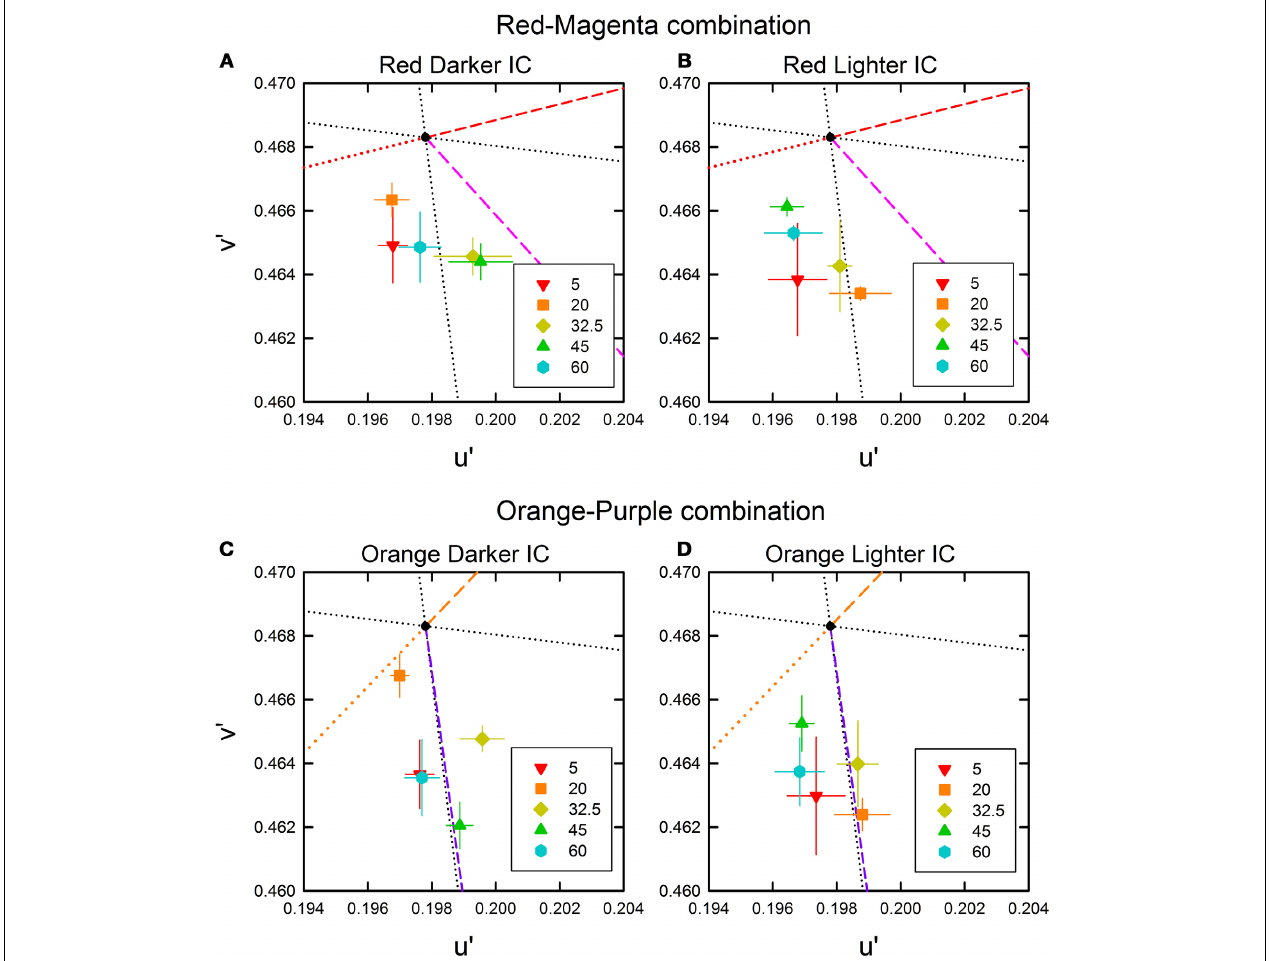
FIGURE 5 | Color cancelation data of Experiment 2 plotted in the CIE u (cid:2) v (cid:2) chromaticity diagram. (A,B) The results for the red IC and magenta OC combination,and (C,D) theresultsfortheorangeICandpurpleOCcombination. For each color combination, the left panel (A,C) shows the results obtained